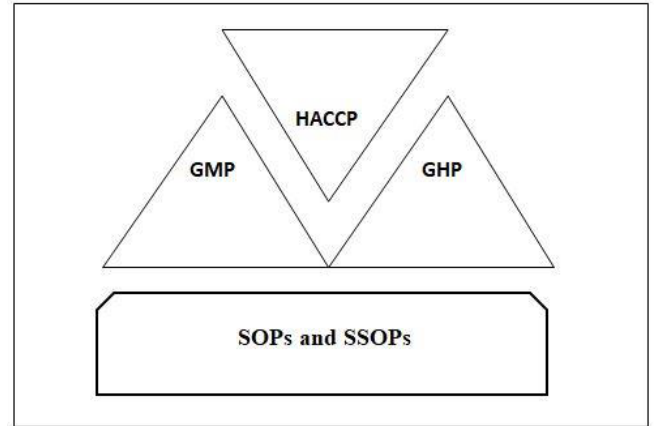
Fig. 1: GMP and GHP are prerequisite programs for HACCP, and SOPs with SSOPs are prerequisite for GMP and